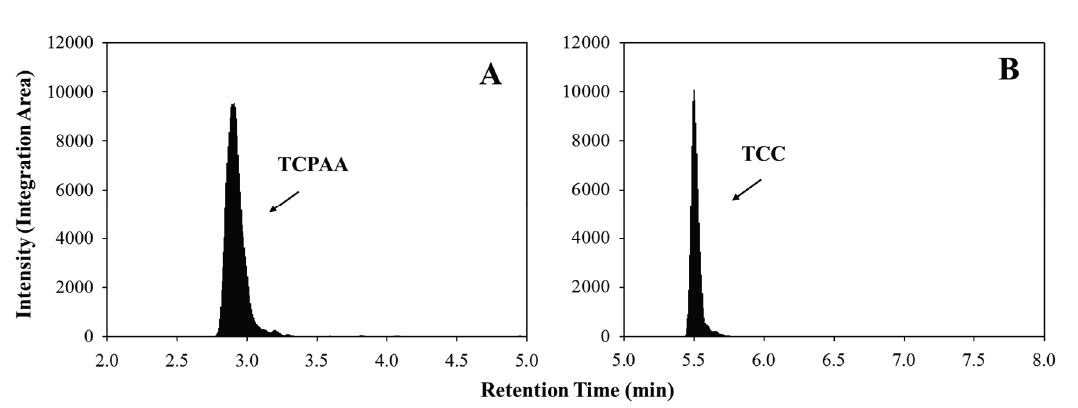
Figure 1. Typical HPLC-MS/MS ion chromatograms from fecal matrix; ( A ) Integration area of representative TCPAA spike in fecal matrix; ( B ) 10 ng/mL TCC spiked blank fecal